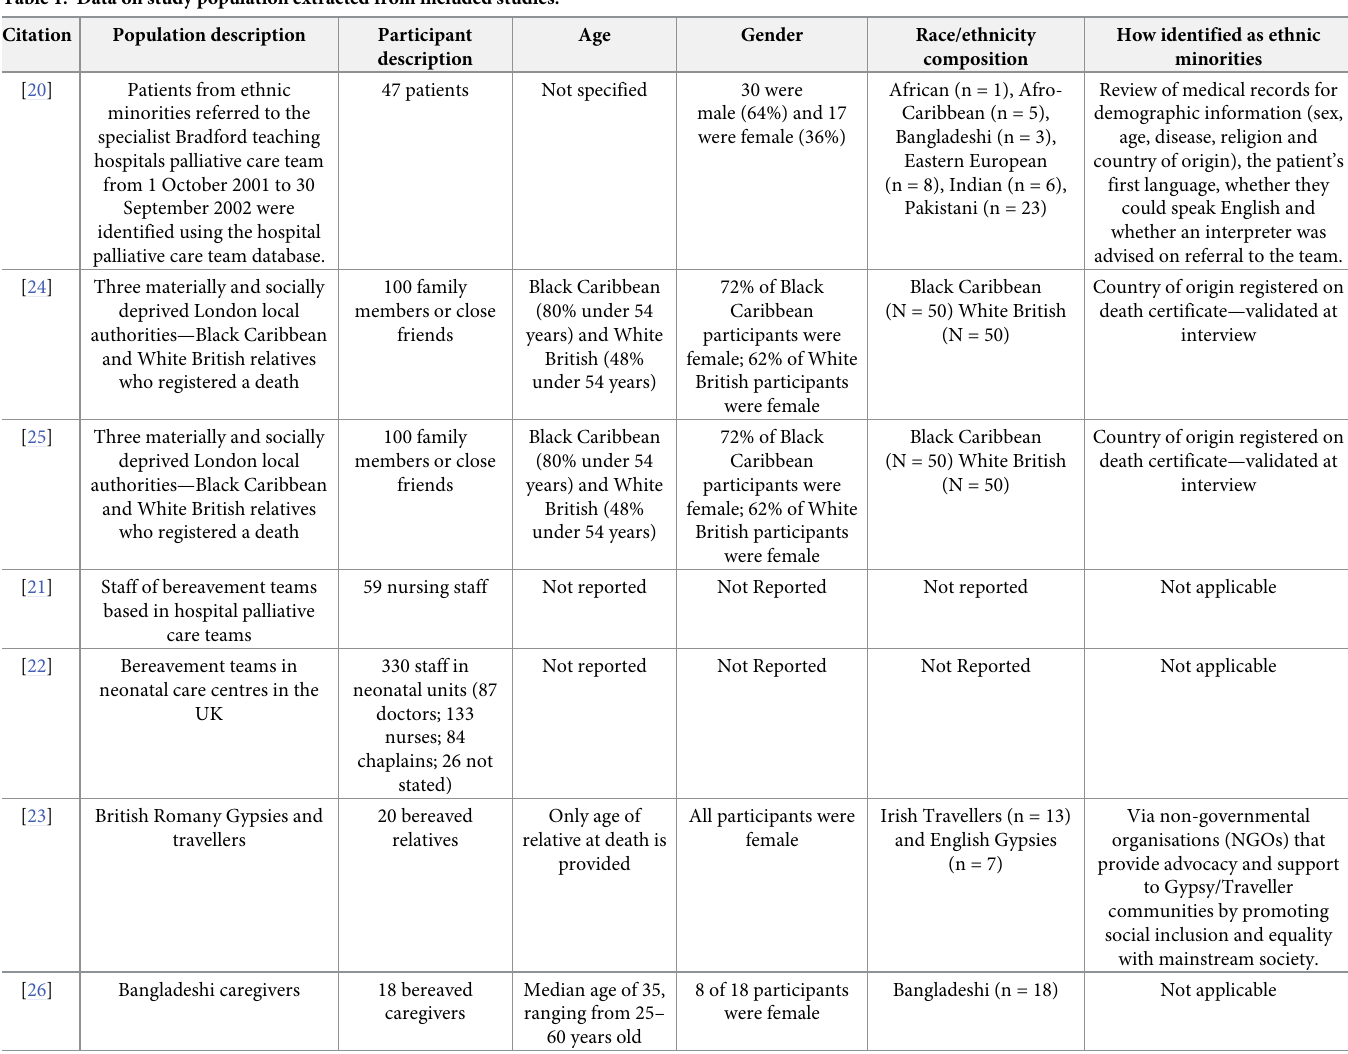
Table 1. Data on study population extracted from included studies.